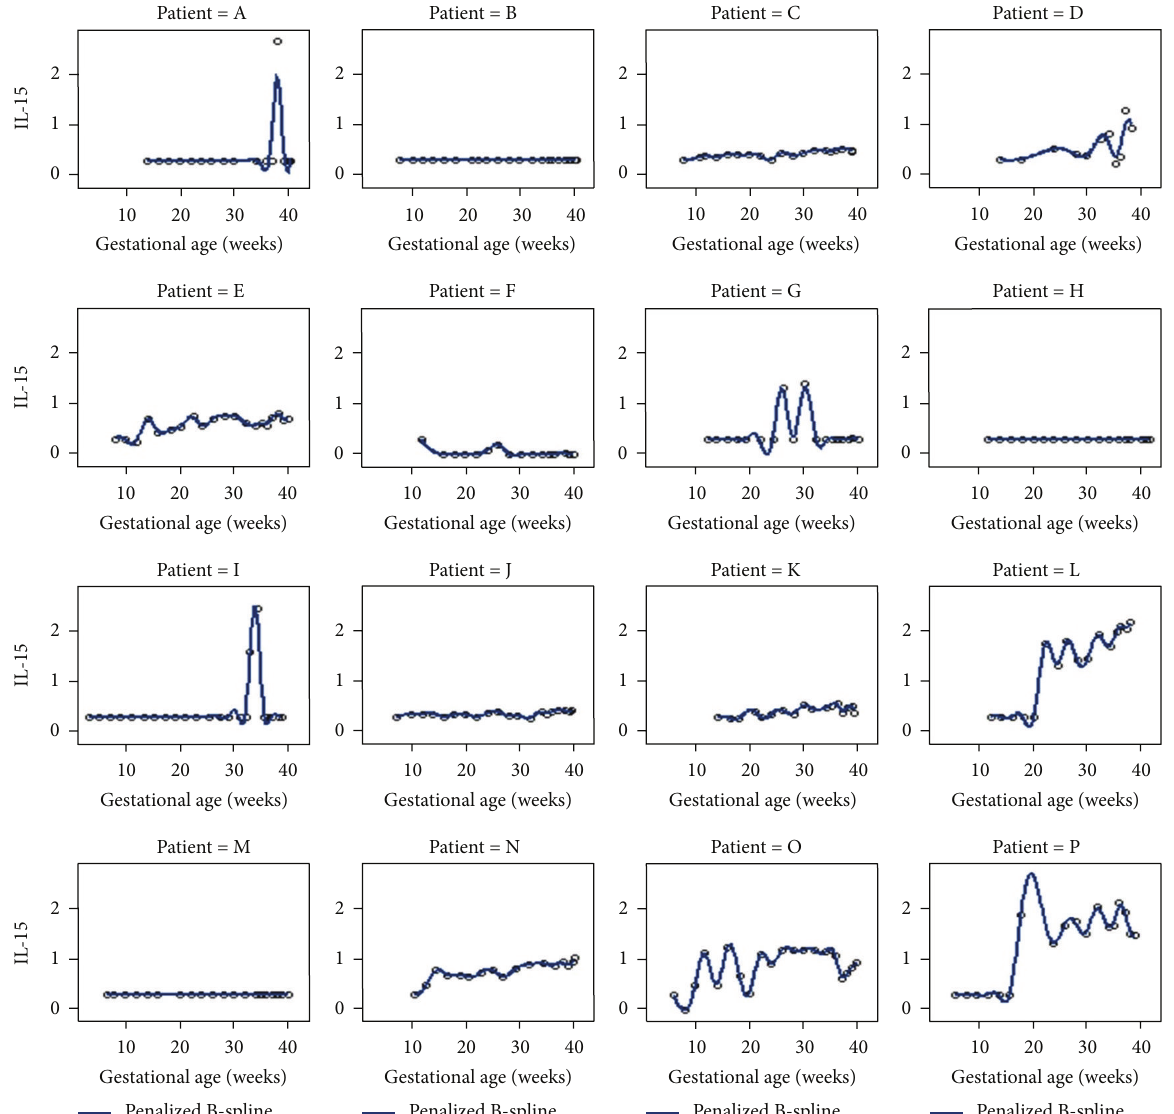
Figure 3: Nonparametric empirical growth trajectory of IL-15 using